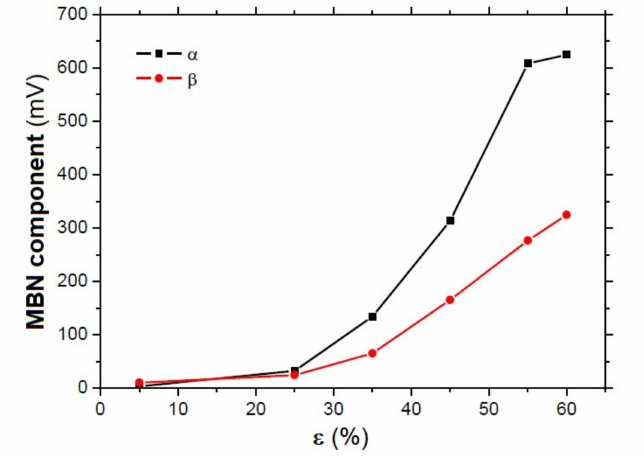
Figure 10. Evolution of isotropic and anisotropic components of MBN versus ε .